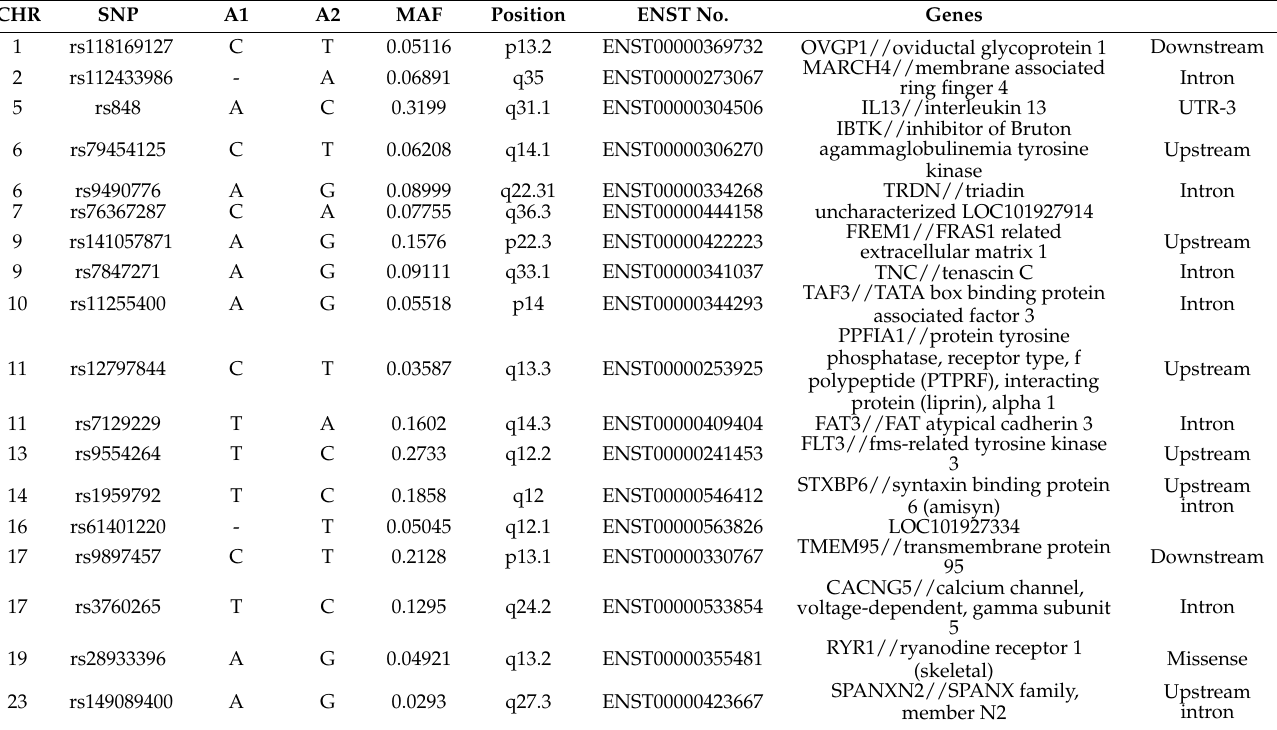
Table 5. The corresponding genes for selected SNP